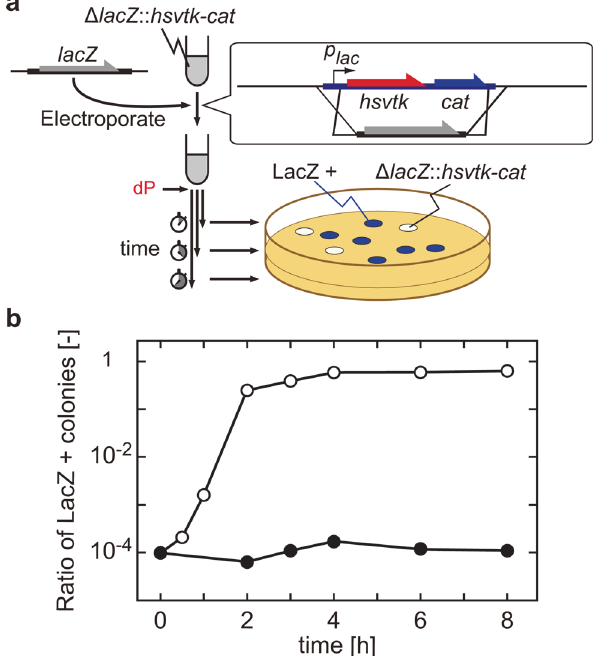
Fig 3. Liquid-based counter-selection using dP kinase activity. (a) Experimental procedure. The selection cassette inserted in lacZ region of E . coli chromosome was replaced back to lacZ by eletroporating PCR-generated lacZ gene. Transformant cells were incubated at 37°C in dP-containing LB medium, and a portion of the culture were plated at each time points (0 – 8 hrs). The number of recombinants was estimated by counting the number of blue colonies per plate. (b) Ratio of recombinant cells (LacZ +) various periods after adding dP, with (open circles)/without (closed circles) dP treatment (1 μ M).